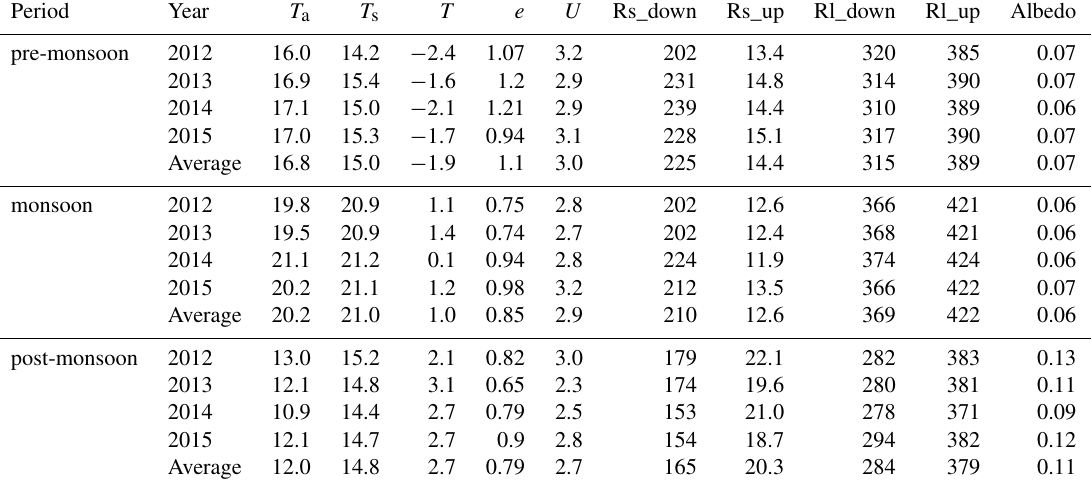
Table 1. Daily average air temperature ( T a , ◦ C), water surface temperature ( T s , ◦ C), difference between water surface temperature and air temperature ( (cid:49)T , ◦ C), vapor pressure difference ( e , kPa) between water surface ( e s , kPa) and the air ( e a , kPa), wind speed ( U , ms − 1 ), the downward and upward shortwave radiation flux (Rs_down and Rs_up, Wm − 2 ), the downward and upward long wave radiation flux (Rl_down and Rl_up, Wm − 2 ), and albedo during pre-monsoon, monsoon and post-monsoon periods from 2012 to 2015. Period Year T a T s T e U